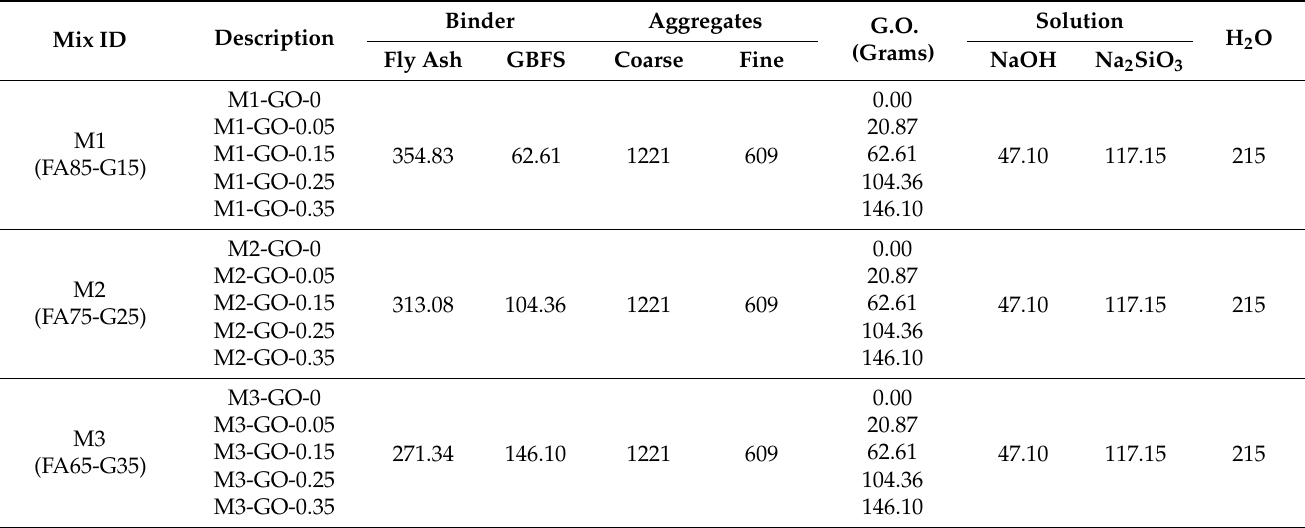
Table 3. Mixture proportion of specimens (kg/m 3